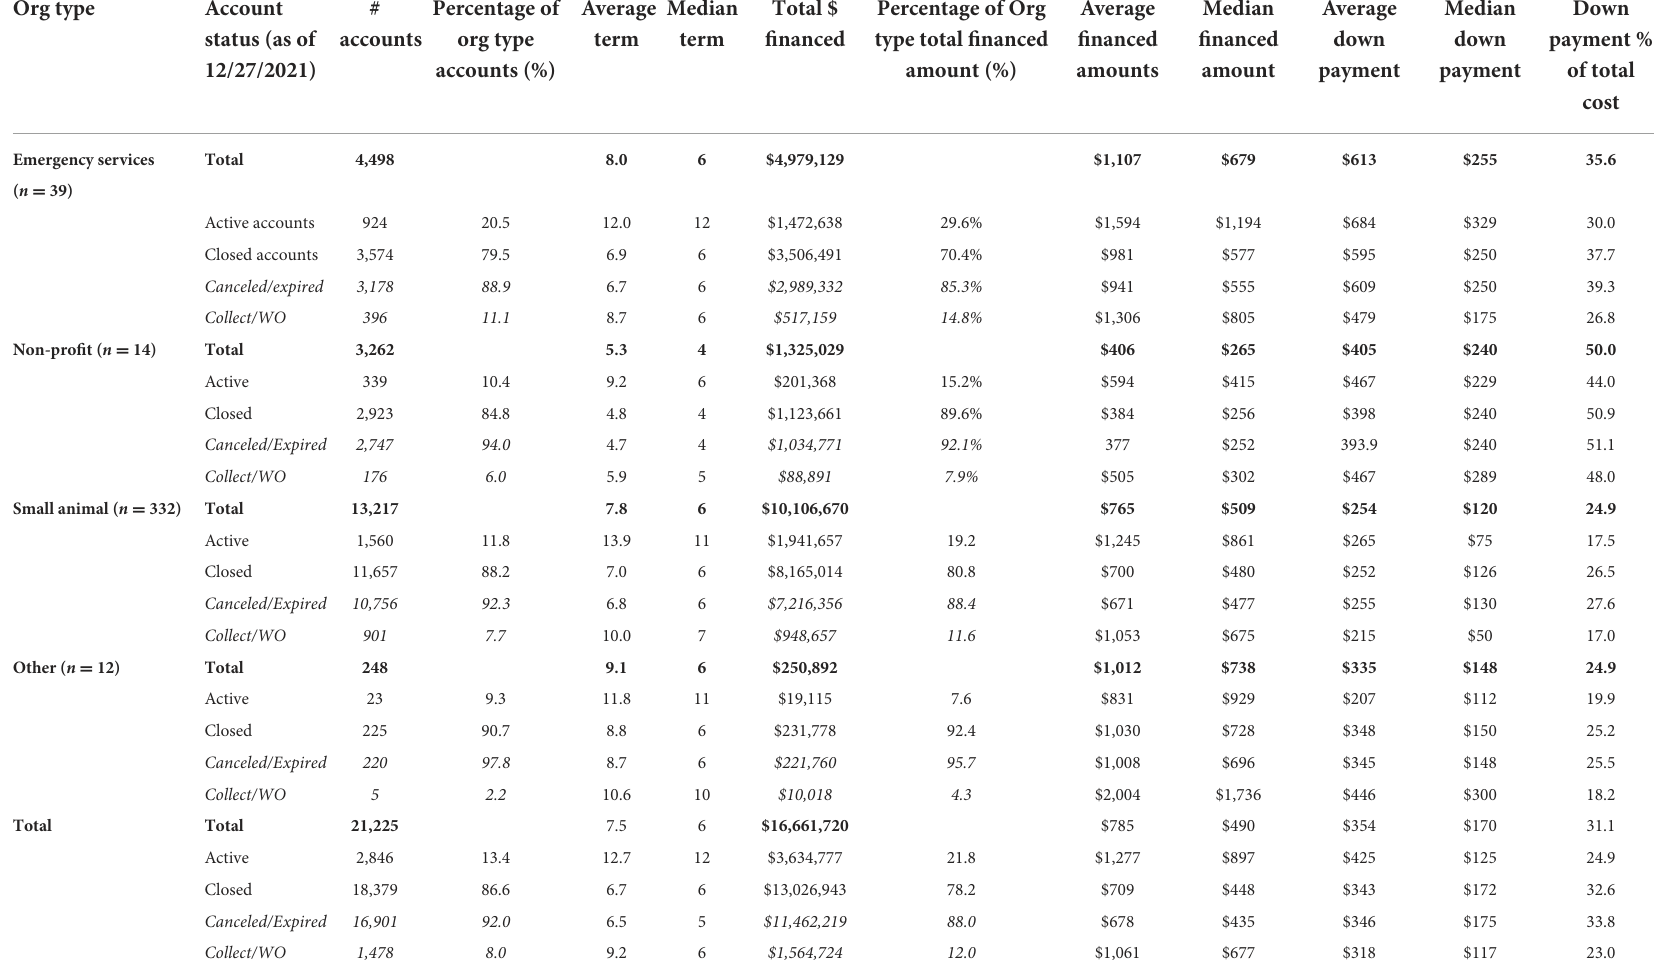
TABLE 1 Organization type